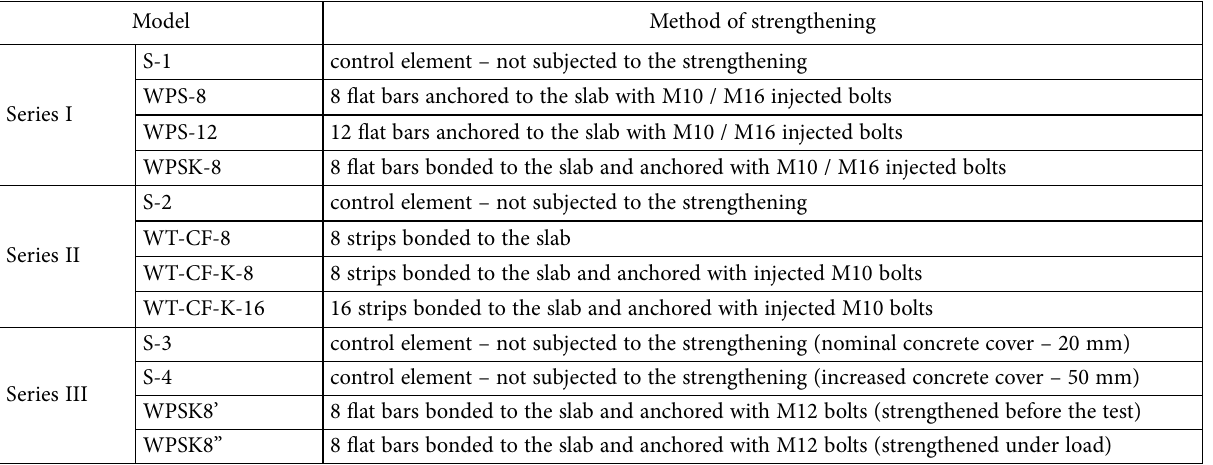
Table 4. The method of strengthening of the models considered in the research by Urban et al. (2010), Urban and Tarka (2010) Model Method of